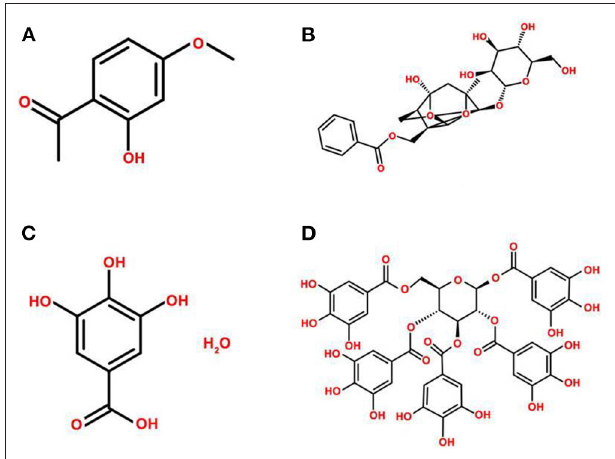
FIGURE 2 | Chemical structures of the main active ingredients of Paeonia suffruticosa . (A) paeonol, (B) paeoniflorin, (C) gallic acid, (D) 1,2,3,4,6-pentakis-O-galloyl- β -D-glucose.